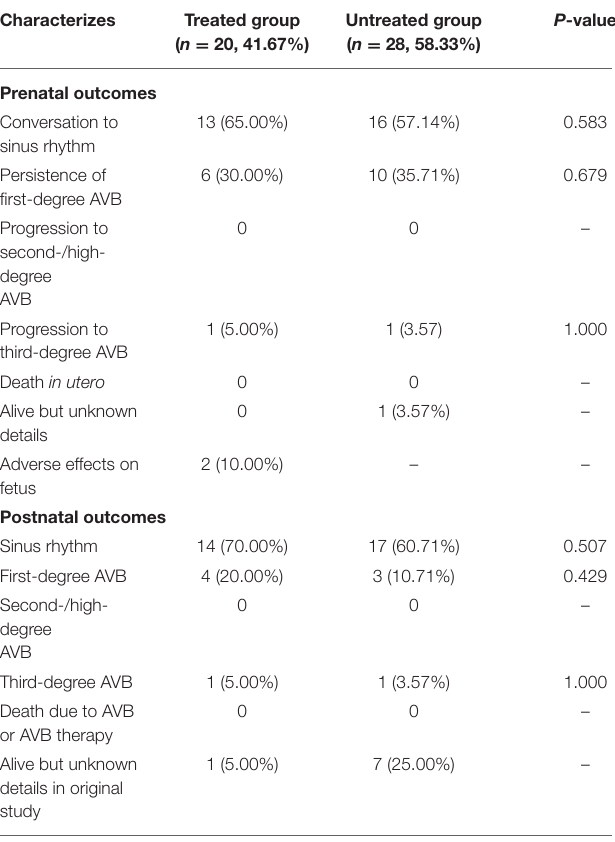
TABLE 2 | The comparison of fetal outcomes of autoimmune-associated first-degree AVB diagnosed initially between treated cases and untreated cases. Characterizes Treated group ( n = 20,